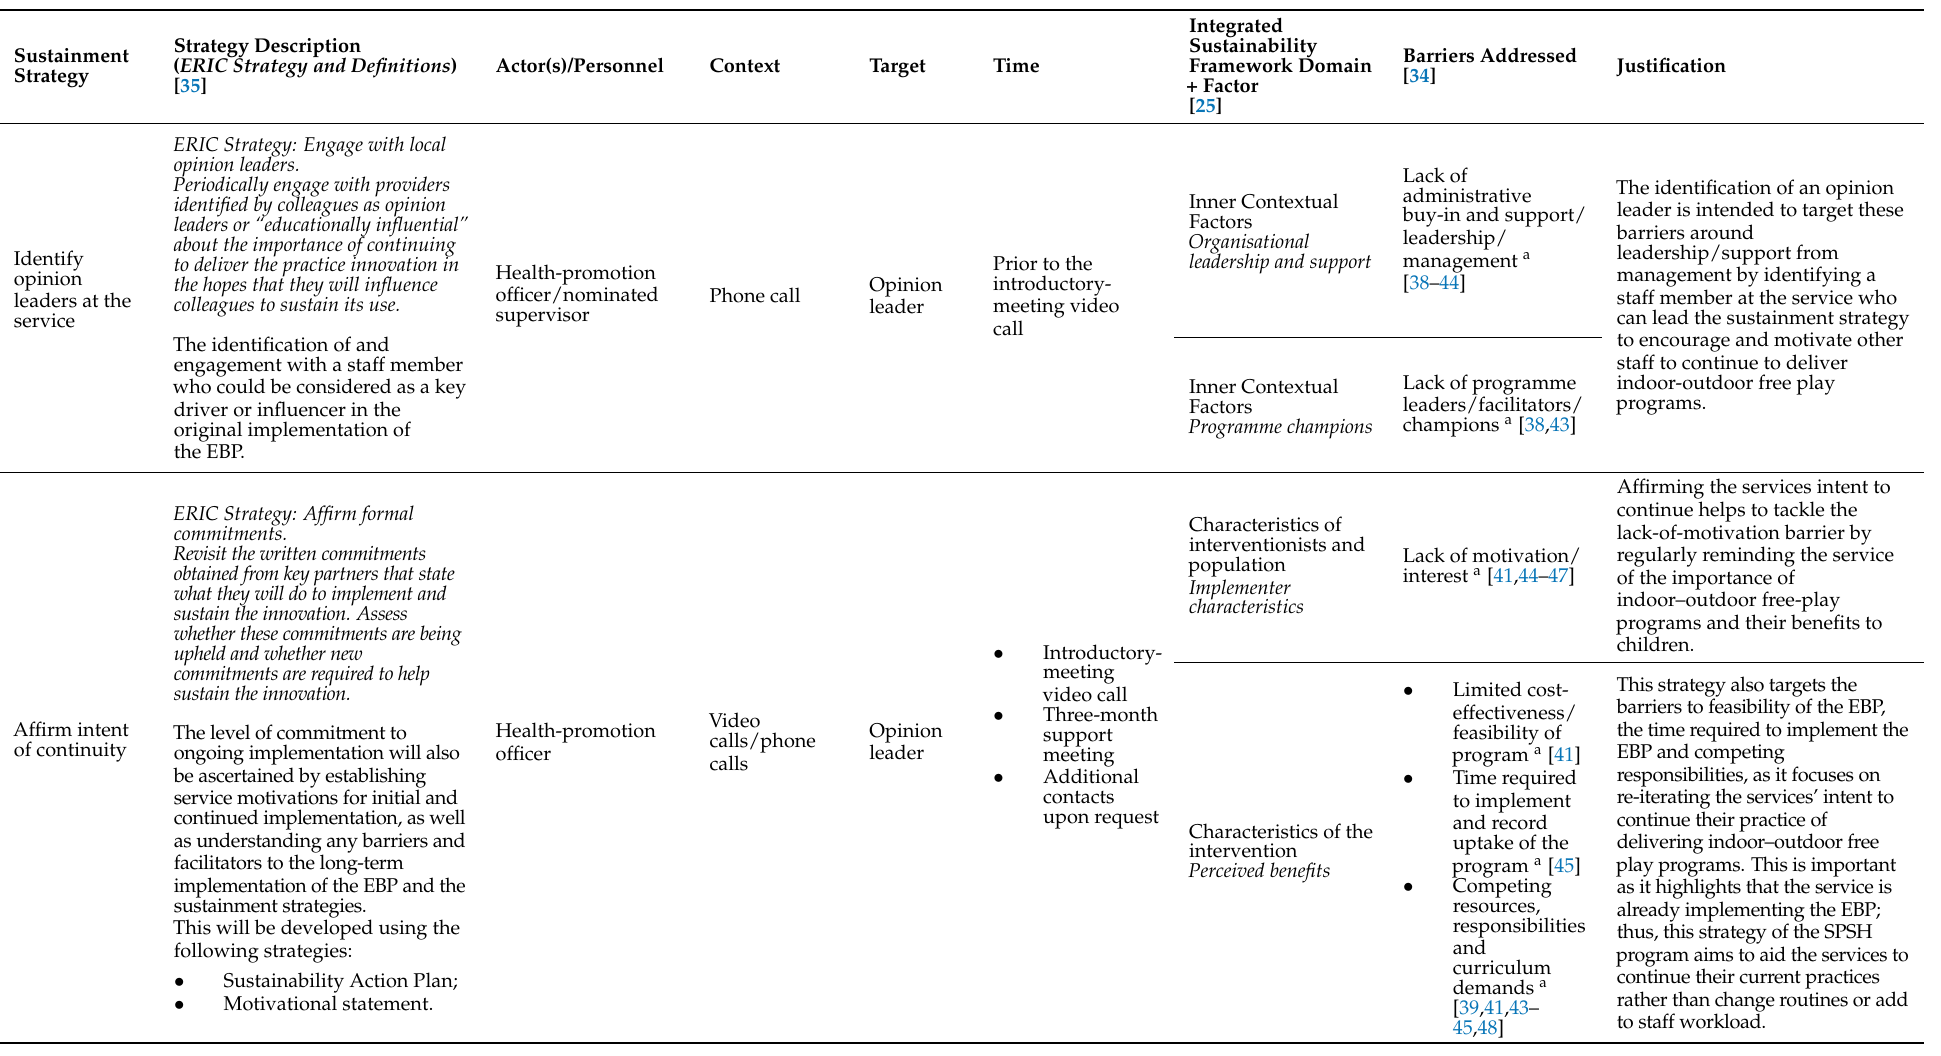
Table 1. Mapping of sustainment strategies against the Integrated Sustainability Framework and the Action, Actor, Context, Target, Time (AACTT) Framework